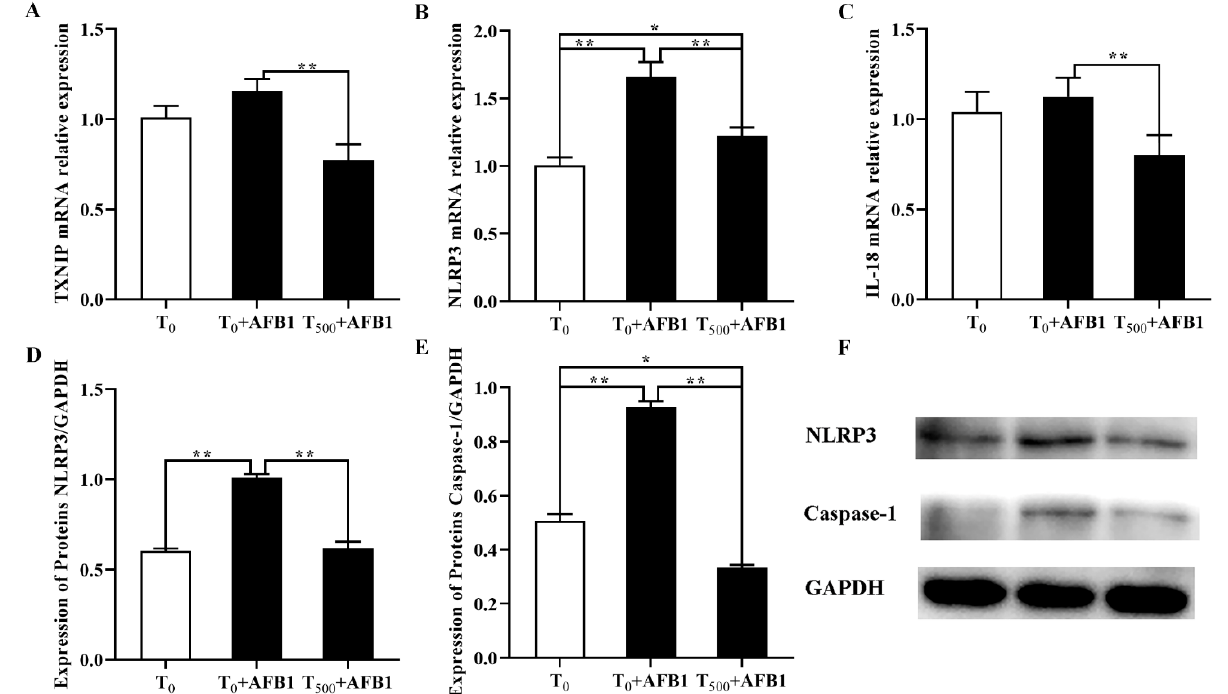
Figure 8. Expression of molecules in NLRP3–caspase-1 signaling way in liver of ducks exposed to AFB1 at 12 h. ( A ) TXNIP gene expression in the liver of ducks; ( B ) NLRP3 gene expression in the liver of ducks; ( C ) IL-18 gene expression in the liver of ducks; ( D ) NLRP3 protein expression in the liver of ducks; ( E ) NLRP3 protein expression in the liver of ducks; ( F ) Caspase-1 protein expression in the liver of ducks. Values mean the mean ± SEM, * means p < 0.05, ** means p < 0.01.